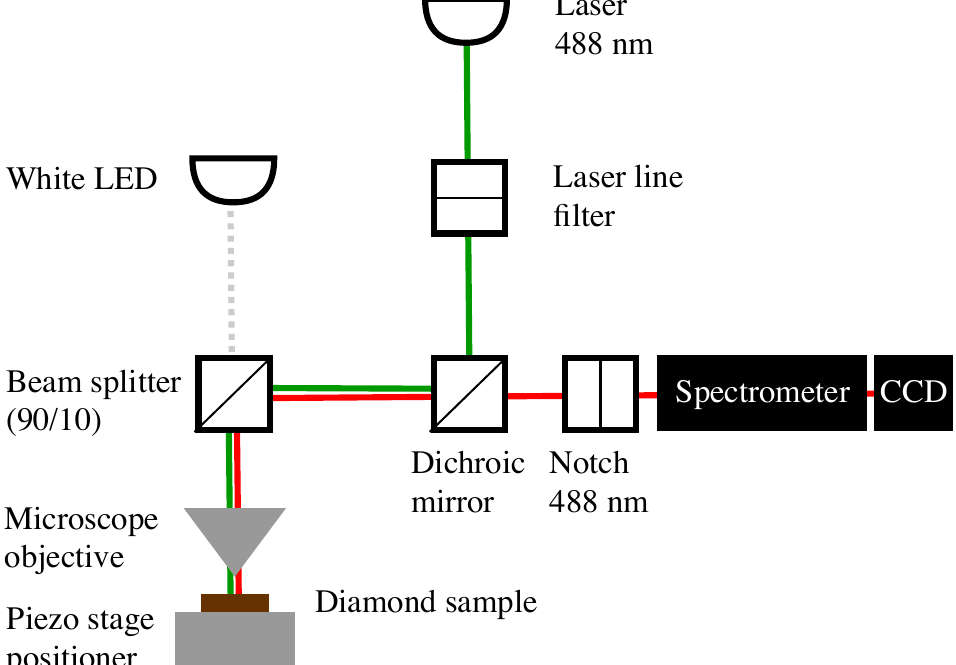
Figure 3. Experimental setup used for the characterization of the samples. It includes a 488 nm laser source, a piezo-positioner, a microscope objective lens, a dichroic mirror (94:06), a 488 nm notch filter, a beam splitter (90:10) a CCD camera, a spectrometer and other optical elements as shown in the diagram. The laser power source is 40 µ W which is partially absorbed by the dichroic mirror and the splitter, reducing the power incident on the sample to 11.25 µ W. The white LED is used for lighting and navigating the